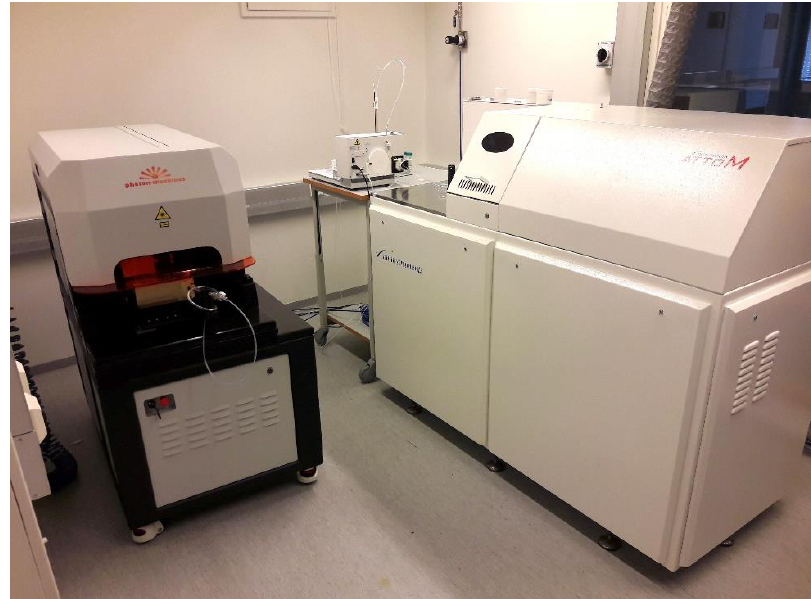
Figure 2. The Analyte Excite ArF laser ablation device, coupled with a Nu Instruments Attom single collector inductively coupled plasma–mass spectrometer.